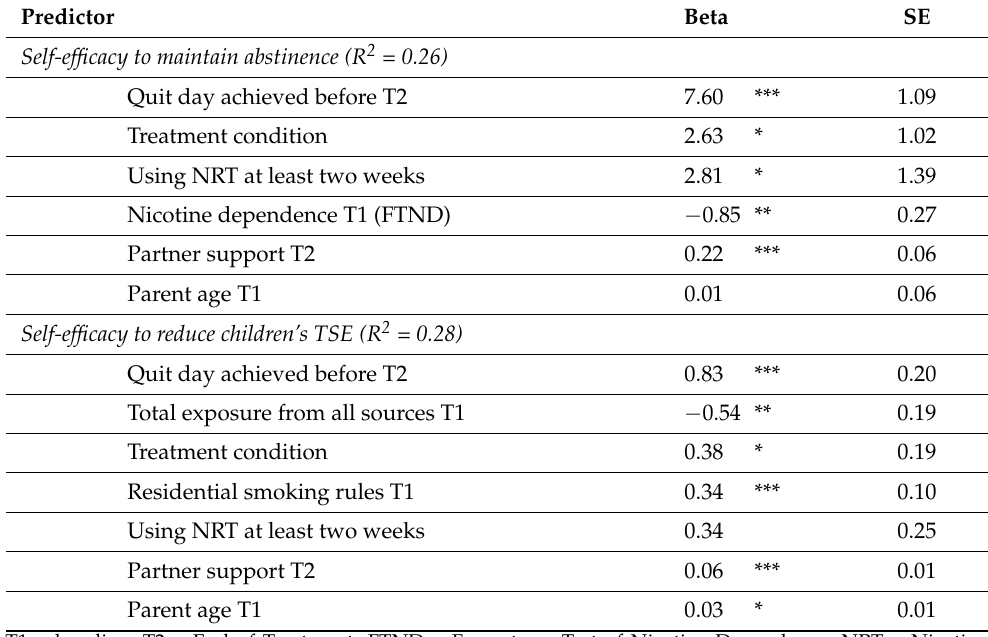
Table 2. Predictors of self-efficacy to abstain from smoking and self-efficacy to reduce children’s TSE (N =